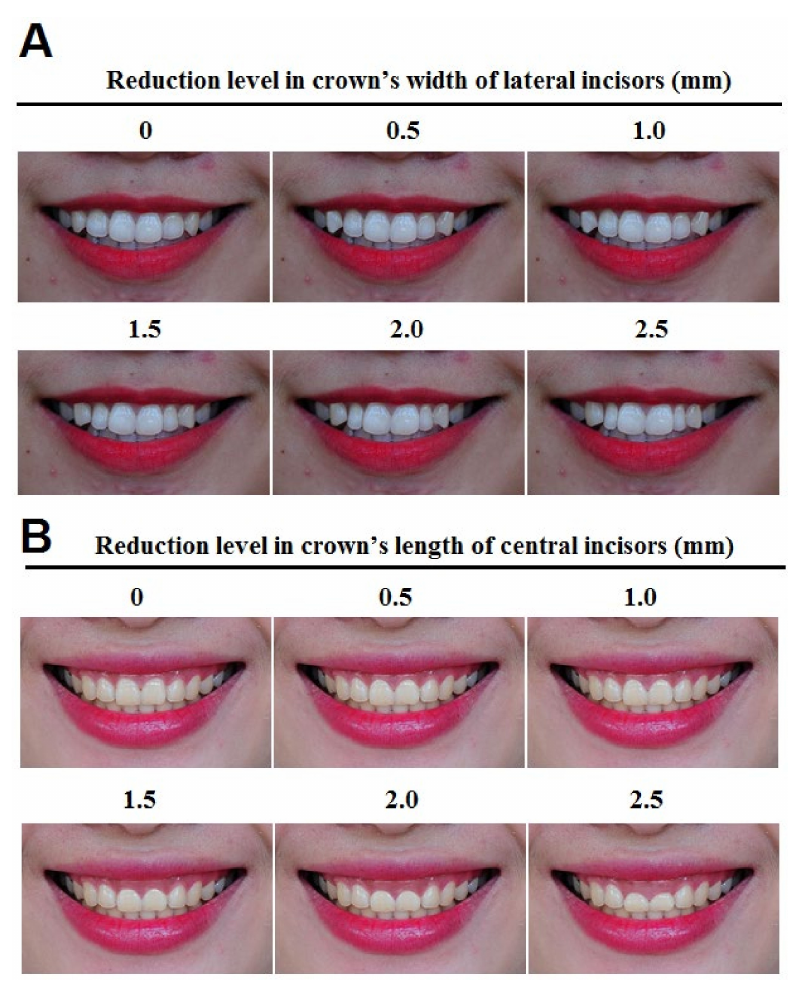
Figure 1. Modification on the crown’s width of maxillary lateral incisors ( A ), and on the crown’s length of maxillary centrals ( B